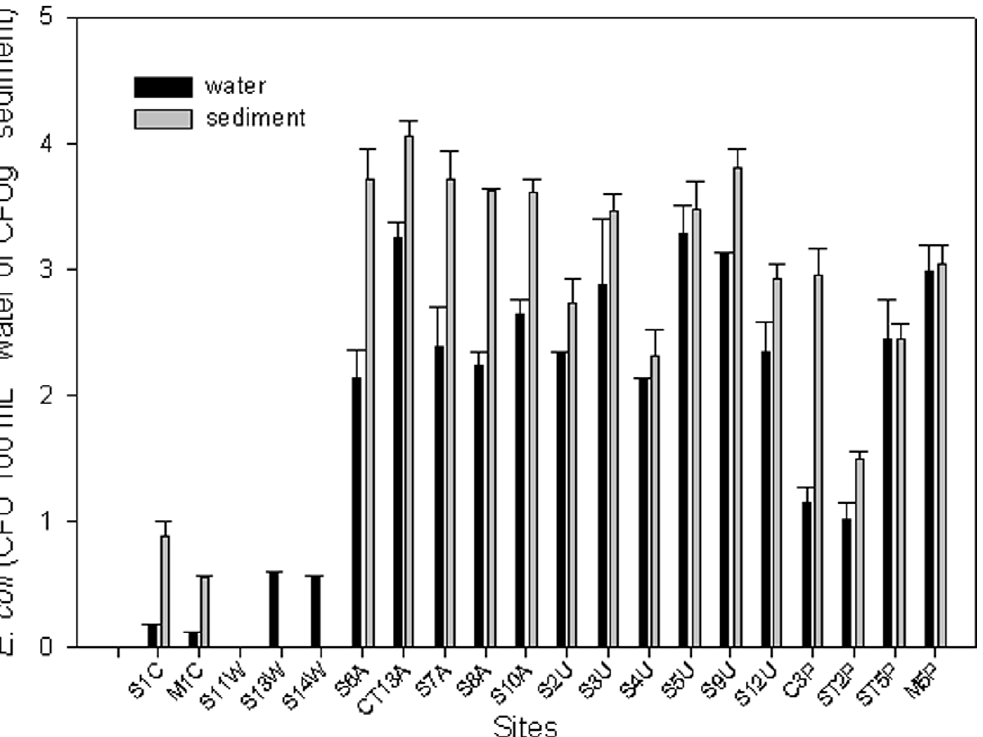
Figure 2. The abundance of E.coli isolates in sediment and surface water samples (n=450) collected from 20 sites over a 12-month period. Counts ranged from undetectable (detection limit 1 CFU 100 ml 2 1 ), in the surface water, to 2.5 6 10 4 CFU 100 ml 2 1 in the sediment. Sample names on the X axis are as shown in Figure 1 and Table 1 with letters C, W, A, U and P representing control sites, WWTPs, agricultural runoff, urban runoff and Prado Park recreational area. Samples are S1C and M1C (control sites); S11W, S13W, and S14W were collected from the outlets at the three WWTPs; S6–S10A from agricultural inputs; S2U to S12U are from urban runoff, C3P, ST2P, ST5P, and M5P are from locations in and around the Prado recreational park. Error bars represent standard errors of two replicate